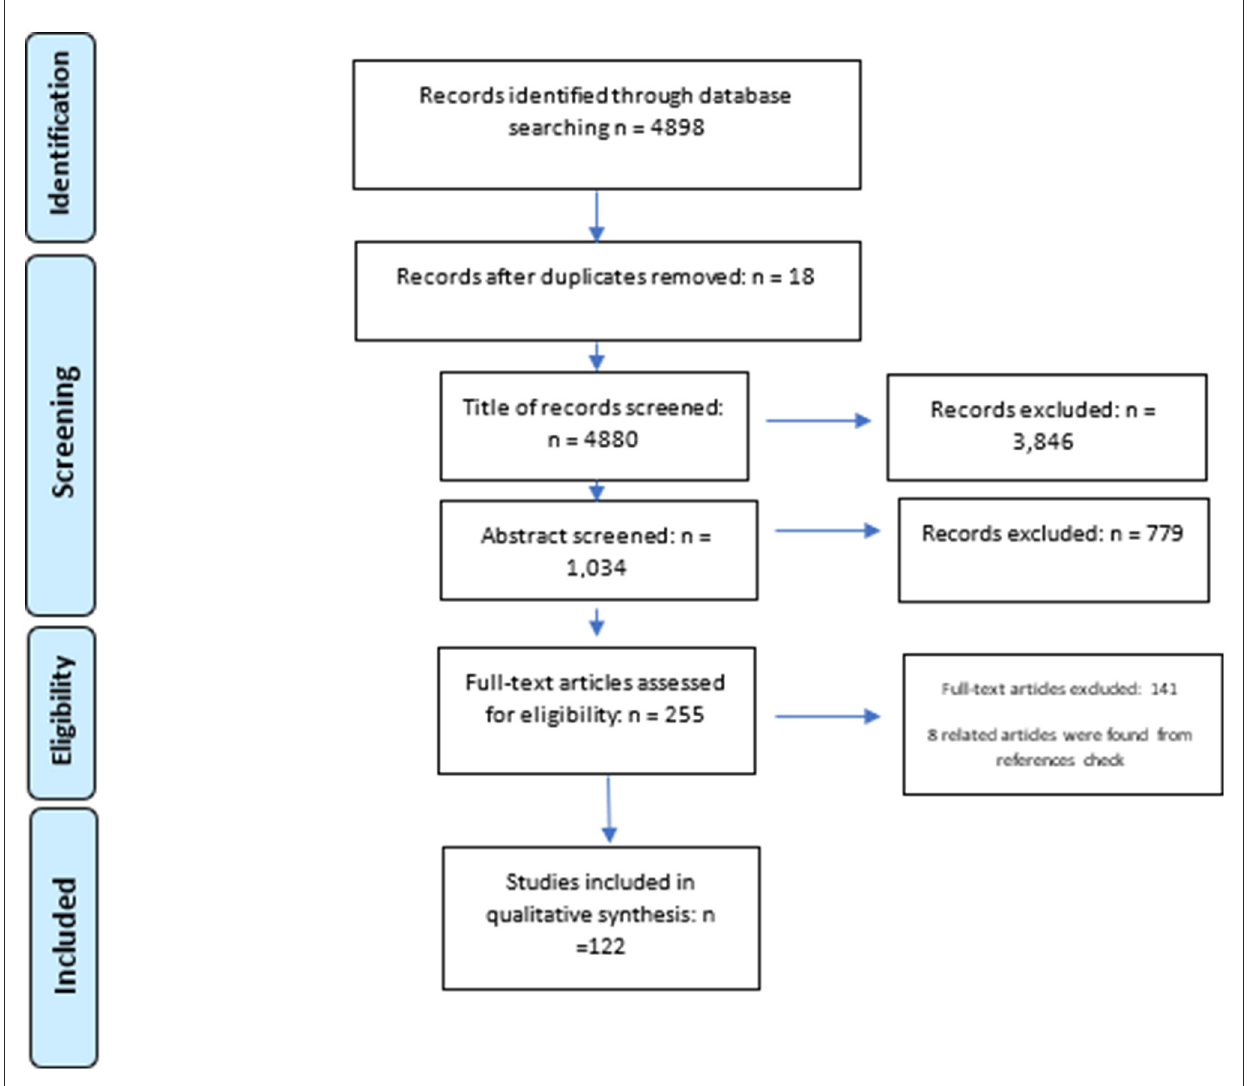
FIGURE1 PRISMA flow diagram depicting the study selection process.